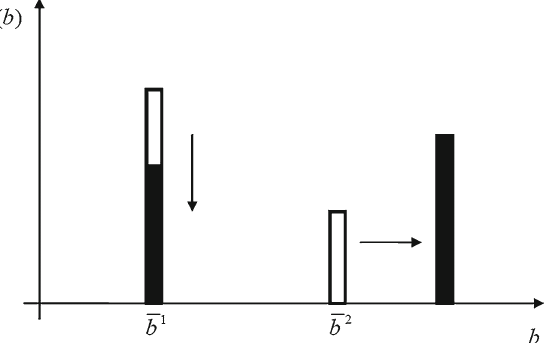
Fig. 6 The effect on the distribution of bequests of a marginal increase in the education subsidy. (Source: Alonso-Carrera et al.